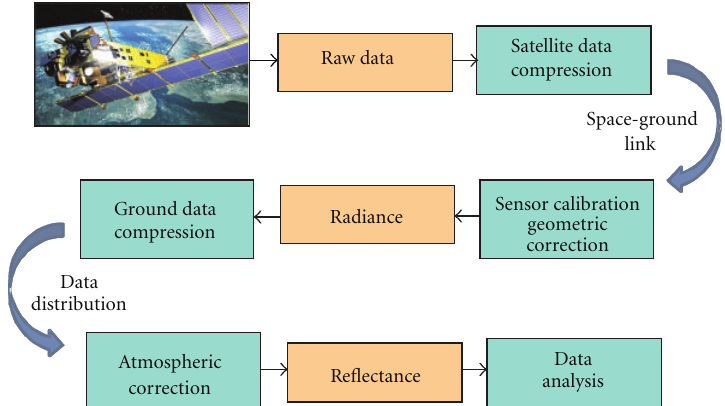
Figure 2: Flowchart of satellite hyperspectral processing chain. Compressed data are decoded before successive processing.